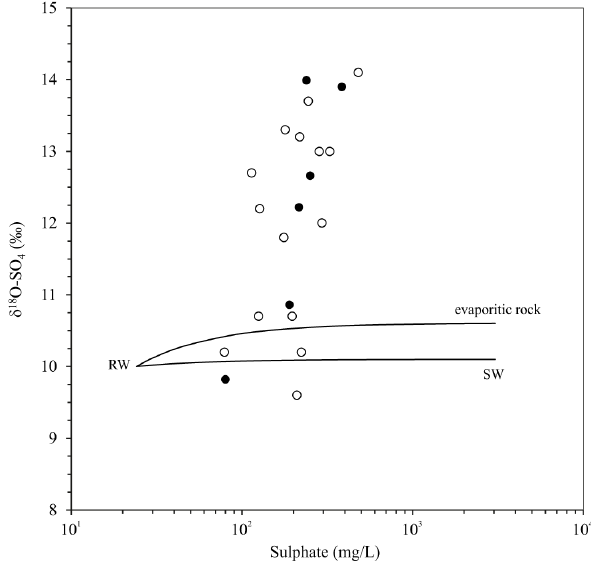
Fig. 9. Plot of δ 18 O-SO 4 and SO 4 concentrations with mixing lines between rainwater and seawater and rainwater and collected evap- orites (mean value of δ 18 O-SO 4 is